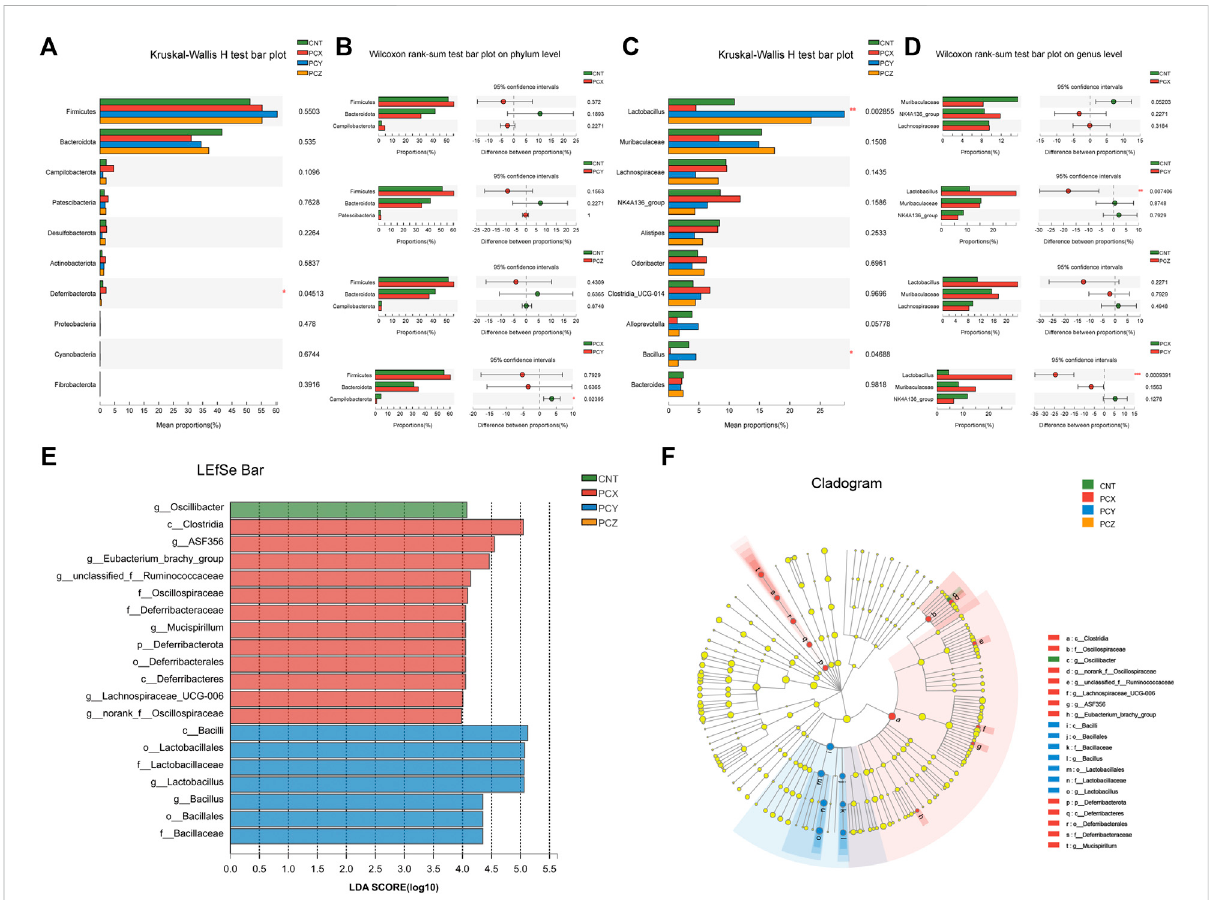
FIGURE 3 (A) Kruskal-Wallis H test bar plot of fecal microbiota at the phylum level. (B) Wilcoxon rank-sum test bar plot of fecal microbiota at the phylum level between the two groups. (C) Kruskal-Wallis H test bar plot of fecal microbiota at the genus level. (D) Wilcoxon rank-sum test bar plot of